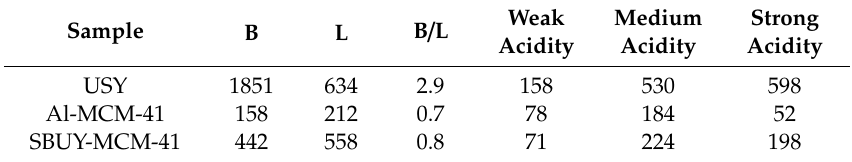
Table 2. Acidity properties of USY, SBUY-MCM-41, and Al-MCM-41 ( µ mol g − 1